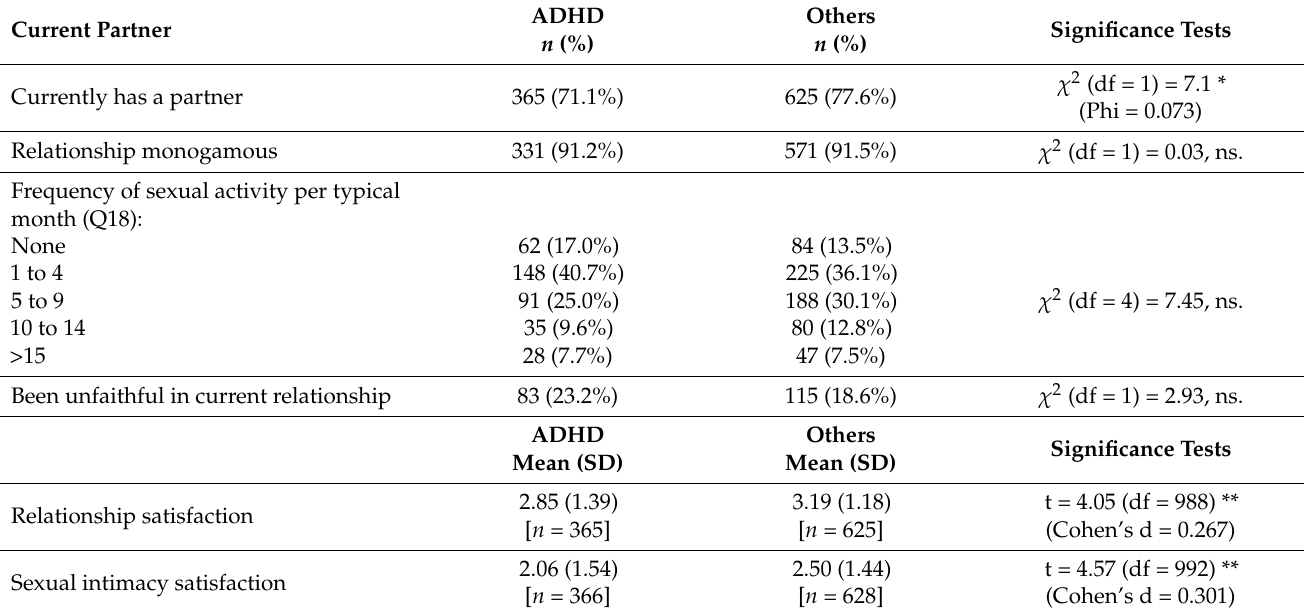
Table 4. Sexual engagement and relationship satisfaction for ADHD and Other